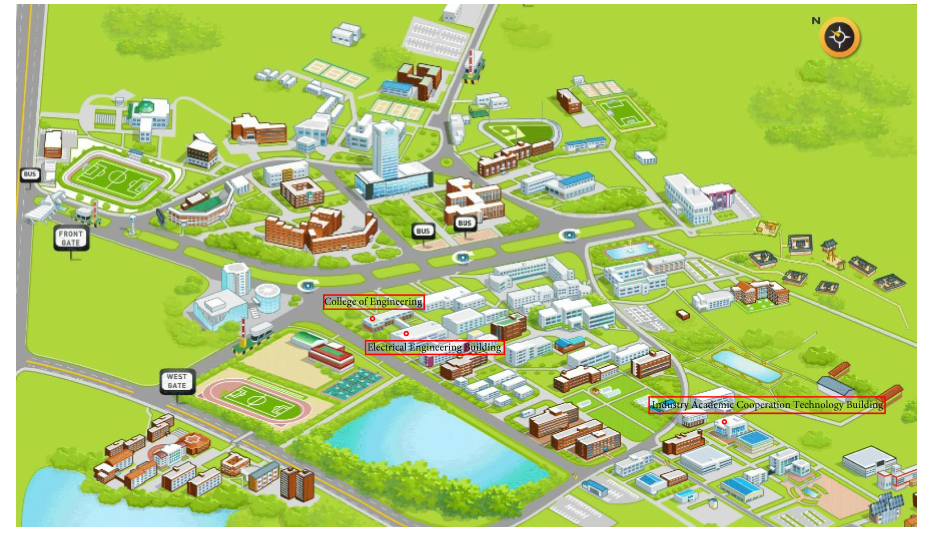
Figure 11. Locations of the test buildings on the map.